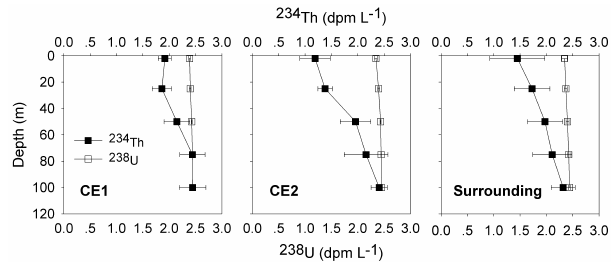
Fig. 2. Depth profiles of nutrient concentration averaged over re- spective stations inside and outside the eddies and the reference site (St. SEATS). Value “0” means below the detection limit of the stan- dard spectrophotometric methods. Error bars indicate standard de- viations.